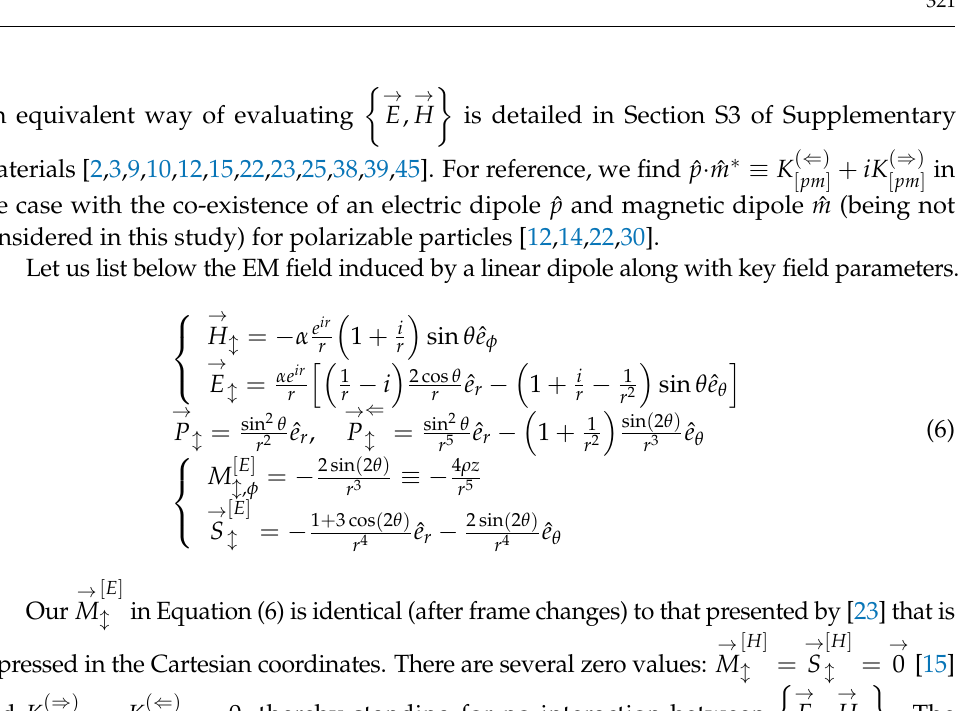
  Figure 1. ( a ) Decomposition of a Poynting vector P into an orbital energy flux O and a spin     energy flux S . Besides, M is a spin angular momentum (SAM) density. ( b ) The coordinate Figure 1. ( a ) Decomposition of a Poynting vector P into an orbital energy flux O and a spin   systems. On the origin lies a primary electric point dipole represented by its unit vector ˆ p . ( c ) A     energy flux S . Besides, M is a spin angular momentum (SAM) density. ( b ) The coordinate Figure 1. ( a ) Decomposition of a Poynting vector P into an orbital energy flux O and a spin Figure 1. ( a ) Decomposition of a Poynting vector P into an orbital energy flux O and a spin linear dipole ˆ p with its dipole axis lying parallel to the vertical axis leads to a pencil-hull-like      systems. On the origin lies a primary electric point dipole represented by its unit vector ˆ p . ( c ) A   energy flux S energy flux S . Besides, M is a spin angular momentum (SAM) density. ( b ) The coordinate . Besides, M is a spin angular momentum (SAM) density. ( b ) The coordinate tapered cylindrical surface designating higher values for the degree of circular polarization (DoCP). Figure 1. ( a ) Decomposition of a Poynting vector P into an orbital energy flux O and a spin linear dipole ˆ p with its dipole axis lying parallel to the vertical axis leads to a pencil-hull-like      systems. On the origin lies a primary electric point dipole represented by its unit vector ˆ p . ( c ) A systems. On the origin lies a primary electric point dipole represented by its unit vector ˆ p . ( c ) A with its dipole axis lying on the horizontal plane leads to a filled solid ( d ) A circular dipole ˆ p energy flux S . Besides, M is a spin angular momentum (SAM) density. ( b ) The coordinate  Figure 1. ( a ) Decomposition of a Poynting vector P into an orbital energy flux O and a spin tapered cylindrical surface designating higher values for the degree of circular polarization (DoCP).   linear dipole ˆ p with its dipole axis lying parallel to the vertical axis leads to a pencil-hull-like linear dipole ˆ p with its dipole axis lying parallel to the vertical axis leads to a pencil-hull-like systems. On the origin lies a primary electric point dipole represented by its unit vector ˆ p . ( c ) A ○ cone of higher values of DoCP.    energy flux S . Besides, M is a spin angular momentum (SAM) density. ( b ) The coordinate  with its dipole axis lying on the horizontal plane leads to a filled solid ( d ) A circular dipole ˆ p   tapered cylindrical surface designating higher values for the degree of circular polarization (DoCP). tapered cylindrical surface designating higher values for the degree of circular polarization (DoCP). Figure 1. ( a ) Decomposition of a Poynting vector P into an orbital energy flux O and a spin linear dipole ˆ p with its dipole axis lying parallel to the vertical axis leads to a pencil-hull-like systems. On the origin lies a primary electric point dipole represented by its unit vector ˆ p . ( c ) A    ○ cone of higher values of DoCP. with its dipole axis lying on the horizontal plane leads to a filled solid with its dipole axis lying on the horizontal plane leads to a filled solid ( d ) A circular dipole ˆ p ( d ) A circular dipole ˆ p   energy flux S . Besides, M is a spin angular momentum (SAM) density. ( b ) The coordinate    tapered cylindrical surface designating higher values for the degree of circular polarization (DoCP). linear dipole ˆ p with its dipole axis lying parallel to the vertical axis leads to a pencil-hull-like Figure 1. ( a ) Decomposition of a Poynting vector P into an orbital energy flux O and a spin  ○ ○ systems. On the origin lies a primary electric point dipole represented by its unit vector ˆ p . ( c ) A  cone of higher values of DoCP. cone of higher values of DoCP.  with its dipole axis lying on the horizontal plane leads to a filled solid ( d ) A circular dipole ˆ p   tapered cylindrical surface designating higher values for the degree of circular polarization (DoCP).   energy flux S . Besides, M is a spin angular momentum (SAM) density. ( b ) The coordinate  linear dipole ˆ p with its dipole axis lying parallel to the vertical axis leads to a pencil-hull-like ○ Figure 1. ( a ) Decomposition of a Poynting vector P into an orbital energy flux O and a spin cone of higher values of DoCP.  with its dipole axis lying on the horizontal plane leads to a filled solid ( d ) A circular dipole ˆ p systems. On the origin lies a primary electric point dipole represented by its unit vector ˆ p . ( c ) A     tapered cylindrical surface designating higher values for the degree of circular polarization (DoCP).  energy flux S . Besides, M is a spin angular momentum (SAM) density. ( b ) The coordinate  [ E ] ○ → cone of higher values of DoCP. linear dipole ˆ p with its dipole axis lying parallel to the vertical axis leads to a pencil-hull-like  Figure 1. ( a ) Decomposition of a Poynting vector P into an orbital energy flux O and a spin  M with its dipole axis lying on the horizontal plane leads to a filled solid ( d ) A circular dipole ˆ p systems. On the origin lies a primary electric point dipole represented by its unit vector ˆ p . ( c ) A    tapered cylindrical surface designating higher values for the degree of circular polarization (DoCP). energy flux S . Besides, M is a spin angular momentum (SAM) density. ( b ) The coordinate ○ cone of higher values of DoCP. linear dipole ˆ p with its dipole axis lying parallel to the vertical axis leads to a pencil-hull-like   with its dipole axis lying on the horizontal plane leads to a filled solid ( d ) A circular dipole ˆ p     systems. On the origin lies a primary electric point dipole represented by its unit vector ˆ p . ( c ) A  Figure 1. ( a ) Decomposition of a Poynting vector P into an orbital energy flux O and a spin Figure 1. ( a ) Decomposition of a Poynting vector P into an orbital energy flux O and a spin tapered cylindrical surface designating higher values for the degree of circular polarization (DoCP).   ○   cone of higher values of DoCP. linear dipole ˆ p with its dipole axis lying parallel to the vertical axis leads to a pencil-hull-like       with its dipole axis lying on the horizontal plane leads to a filled solid ( d ) A circular dipole ˆ p   energy flux S energy flux S . Besides, M is a spin angular momentum (SAM) density. ( b ) The coordinate . Besides, M is a spin angular momentum (SAM) density. ( b ) The coordinate    Figure 1. ( a ) Decomposition of a Poynting vector P into an orbital energy flux O and a spin Figure 1. ( a ) Decomposition of a Poynting vector P into an orbital energy flux O and a spin Figure 1. ( a ) Decomposition of a Poynting vector P into an orbital energy flux O and a spin Figure 1. ( a ) Decomposition of a Poynting vector P into an orbital energy flux O and a spin tapered cylindrical surface designating higher values for the degree of circular polarization (DoCP).       systems. On the origin lies a primary electric point dipole represented by its unit vector ˆ p . ( c ) A systems. On the origin lies a primary electric point dipole represented by its unit vector ˆ p . ( c ) A ○   cone of higher values of DoCP.  energy flux S energy flux S . Besides, M is a spin angular momentum (SAM) density. ( b ) The coordinate . Besides, M is a spin angular momentum (SAM) density. ( b ) The coordinate with its dipole axis lying on the horizontal plane leads to a filled solid ( d ) A circular dipole ˆ p energy flux S energy flux S . Besides, M is a spin angular momentum (SAM) density. ( b ) The coordinate . Besides, M is a spin angular momentum (SAM) density. ( b ) The coordinate  linear dipole ˆ p with its dipole axis lying parallel to the vertical axis leads to a pencil-hull-like linear dipole ˆ p with its dipole axis lying parallel to the vertical axis leads to a pencil-hull-like       systems. On the origin lies a primary electric point dipole represented by its unit vector ˆ p . ( c ) A systems. On the origin lies a primary electric point dipole represented by its unit vector ˆ p . ( c ) A systems. On the origin lies a primary electric point dipole represented by its unit vector ˆ p . ( c ) A systems. On the origin lies a primary electric point dipole represented by its unit vector ˆ p . ( c ) A ○ cone of higher values of DoCP. Figure 1. ( a ) Decomposition of a Poynting vector P into an orbital energy flux O and a spin Figure 1. ( a ) Decomposition of a Poynting vector P into an orbital energy flux O and a spin  tapered cylindrical surface designating higher values for the degree of circular polarization (DoCP). tapered cylindrical surface designating higher values for the degree of circular polarization (DoCP).     linear dipole ˆ p with its dipole axis lying parallel to the vertical axis leads to a pencil-hull-like linear dipole ˆ p with its dipole axis lying parallel to the vertical axis leads to a pencil-hull-like linear dipole ˆ p with its dipole axis lying parallel to the vertical axis leads to a pencil-hull-like linear dipole ˆ p with its dipole axis lying parallel to the vertical axis leads to a pencil-hull-like     with its dipole axis lying on the horizontal plane leads to a filled solid with its dipole axis lying on the horizontal plane leads to a filled solid ( d ) A circular dipole ˆ p ( d ) A circular dipole ˆ p energy flux S energy flux S . Besides, M is a spin angular momentum (SAM) density. ( b ) The coordinate . Besides, M is a spin angular momentum (SAM) density. ( b ) The coordinate   (cid:26) →   tapered cylindrical surface designating higher values for the degree of circular polarization (DoCP). tapered cylindrical surface designating higher values for the degree of circular polarization (DoCP).   tapered cylindrical surface designating higher values for the degree of circular polarization (DoCP). tapered cylindrical surface designating higher values for the degree of circular polarization (DoCP). systems. On the origin lies a primary electric point dipole represented by its unit vector ˆ p . ( c ) A systems. On the origin lies a primary electric point dipole represented by its unit vector ˆ p . ( c ) A ○ ○ cone of higher values of DoCP. cone of higher values of DoCP. Figure 1. ( a ) Decomposition of a Poynting vector P into an orbital energy flux O and a spin Figure 1. ( a ) Decomposition of a Poynting vector P into an orbital energy flux O and a spin E   with its dipole axis lying on the horizontal plane leads to a filled solid with its dipole axis lying on the horizontal plane leads to a filled solid ( d ) A circular dipole ˆ p ( d ) A circular dipole ˆ p   with its dipole axis lying on the horizontal plane leads to a filled solid with its dipole axis lying on the horizontal plane leads to a filled solid ( d ) A circular dipole ˆ p ( d ) A circular dipole ˆ p           linear dipole ˆ p with its dipole axis lying parallel to the vertical axis leads to a pencil-hull-like linear dipole ˆ p with its dipole axis lying parallel to the vertical axis leads to a pencil-hull-like energy flux S energy flux S . Besides, M is a spin angular momentum (SAM) density. ( b ) The coordinate . Besides, M is a spin angular momentum (SAM) density. ( b ) The coordinate   ○ ○ Figure 1. ( a ) Decomposition of a Poynting vector P into an orbital energy flux O and a spin Figure 1. ( a ) Decomposition of a Poynting vector P into an orbital energy flux O and a spin cone of higher values of DoCP. cone of higher values of DoCP. ○ ○ cone of higher values of DoCP. cone of higher values of DoCP.         tapered cylindrical surface designating higher values for the degree of circular polarization (DoCP). tapered cylindrical surface designating higher values for the degree of circular polarization (DoCP). systems. On the origin lies a primary electric point dipole represented by its unit vector ˆ p . ( c ) A systems. On the origin lies a primary electric point dipole represented by its unit vector ˆ p . ( c ) A energy flux S energy flux S . Besides, M is a spin angular momentum (SAM) density. ( b ) The coordinate . Besides, M is a spin angular momentum (SAM) density. ( b ) The coordinate with its dipole axis lying on the horizontal plane leads to a filled solid with its dipole axis lying on the horizontal plane leads to a filled solid ( d ) A circular dipole ˆ p ( d ) A circular dipole ˆ p linear dipole ˆ p with its dipole axis lying parallel to the vertical axis leads to a pencil-hull-like linear dipole ˆ p with its dipole axis lying parallel to the vertical axis leads to a pencil-hull-like   systems. On the origin lies a primary electric point dipole represented by its unit vector ˆ p . ( c ) A systems. On the origin lies a primary electric point dipole represented by its unit vector ˆ p . ( c ) A   ○ cone of higher values of DoCP. tapered cylindrical surface designating higher values for the degree of circular polarization (DoCP). tapered cylindrical surface designating higher values for the degree of circular polarization (DoCP).  linear dipole ˆ p with its dipole axis lying parallel to the vertical axis leads to a pencil-hull-like linear dipole ˆ p with its dipole axis lying parallel to the vertical axis leads to a pencil-hull-like   with its dipole axis lying on the horizontal plane leads to a filled solid with its dipole axis lying on the horizontal plane leads to a filled solid ( d ) A circular dipole ˆ p ( d ) A circular dipole ˆ p   tapered cylindrical surface designating higher values for the degree of circular polarization (DoCP). tapered cylindrical surface designating higher values for the degree of circular polarization (DoCP). ○ ○ cone of higher values of DoCP. cone of higher values of DoCP. with its dipole axis lying on the horizontal plane leads to a filled solid with its dipole axis lying on the horizontal plane leads to a filled solid ( d ) A circular dipole ˆ p ( d ) A circular dipole ˆ p     ○ cone of higher values of DoCP. cone of higher values of DoCP.  